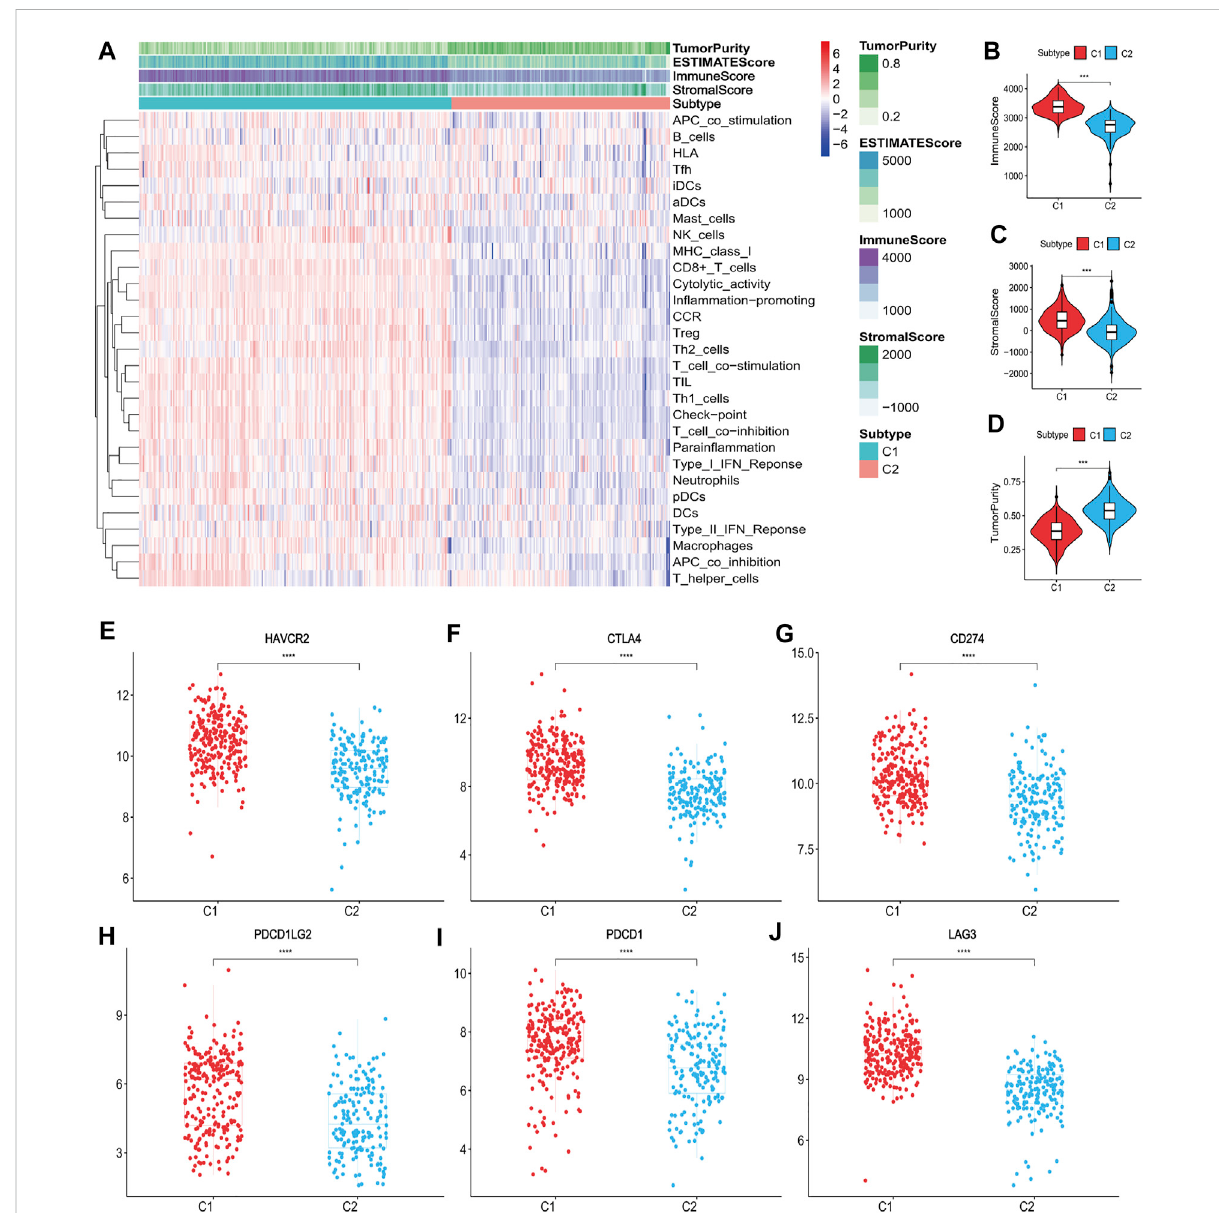
FIGURE 2 Identi fi cation of the two subtypes in thetraining set. (A) Heatmap of thetwo subtypes based on ssGSEA scores for 29 immune gene sets. (B – D) Evaluation of stromal scores, immune scores, ESTIMATE scores and tumor purity for the two subtypes. (E – J) The expression differences of immune checkpoint genes between the two subtypes; Bars indicate medians. Wilcoxon test was used to compare gene expression levels between the two subtypes. *** p < 0.001, **** p <